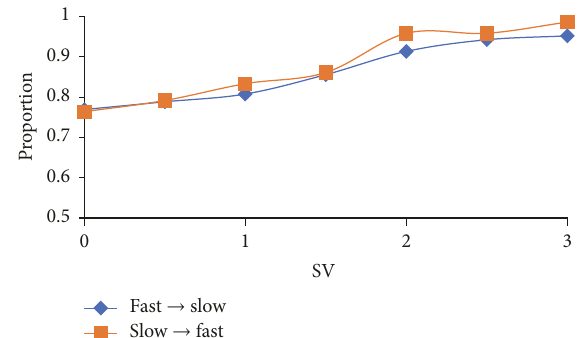
Figure 10: Cumulative frequency diagram of the speed variance of the lagging vehicle on the target